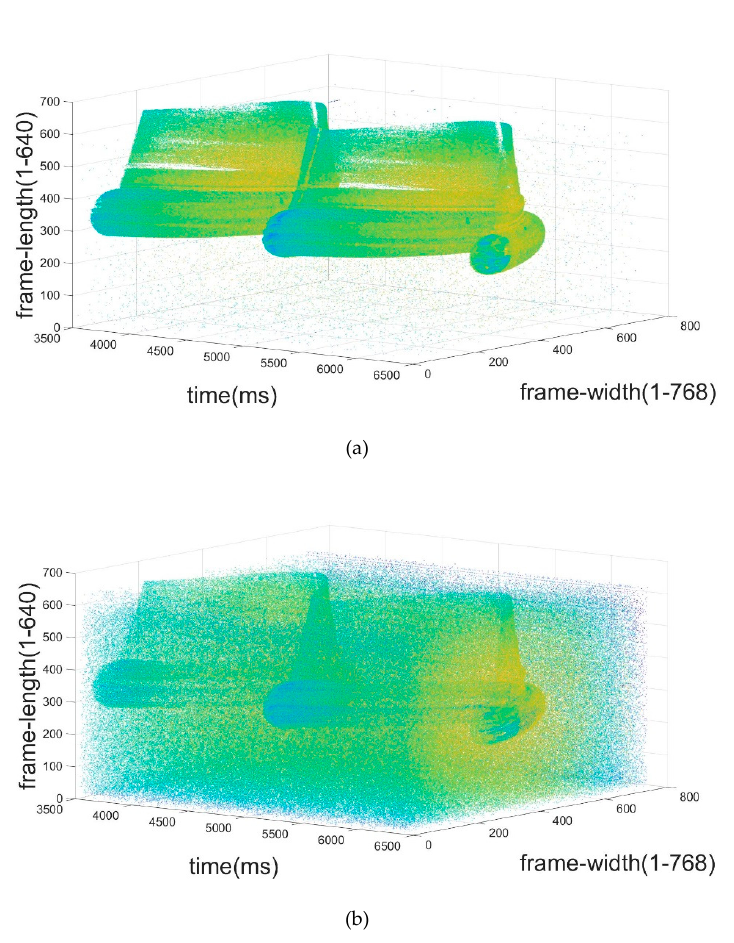
Figure 6. Filtering result of Delbruck’s filter: ( a ) is the result of denoising and ( b ) is the filtered noise.